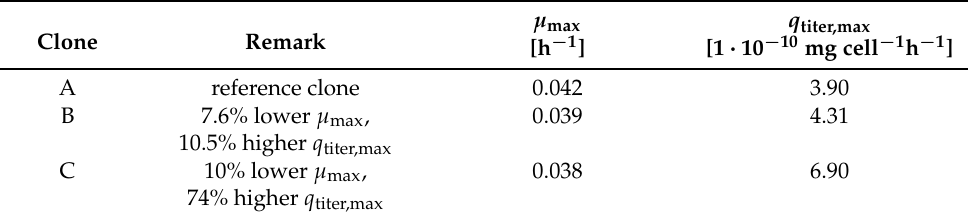
Table 6. Model parameters maximum growth rate µ max and maximum production rate q titer,max of the three clones used for the